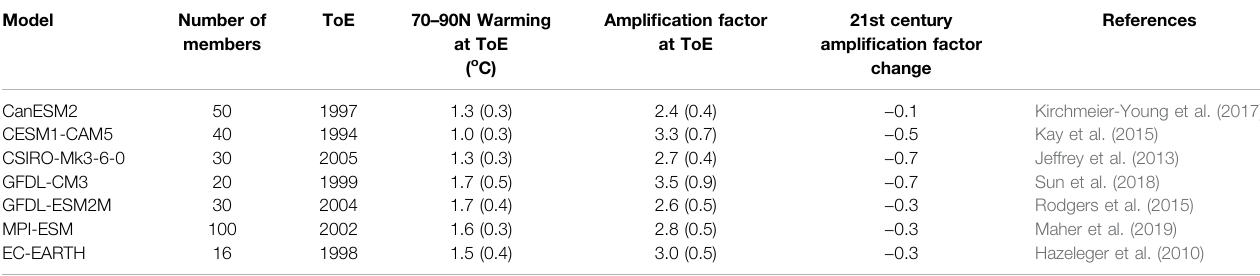
TABLE 1 | Information on the SMILE simulations used in this study and their Arctic ampli fi cation. Properties are shown for annual ensemble mean values. Values in parenthesis indicate the standard deviation across ensemble members. Model Number of